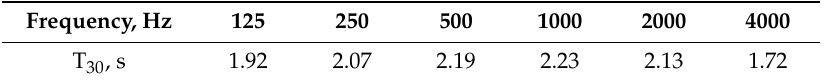
Table 1. Reverberation time in octave band measured in the atrium of the shopping center.